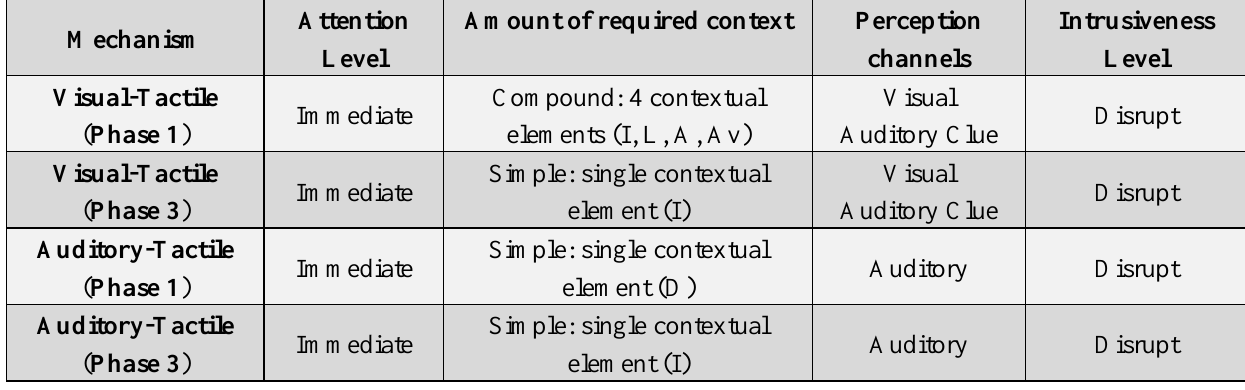
Table 3. Design characteristics of the CANoE notification mechanisms used in this case